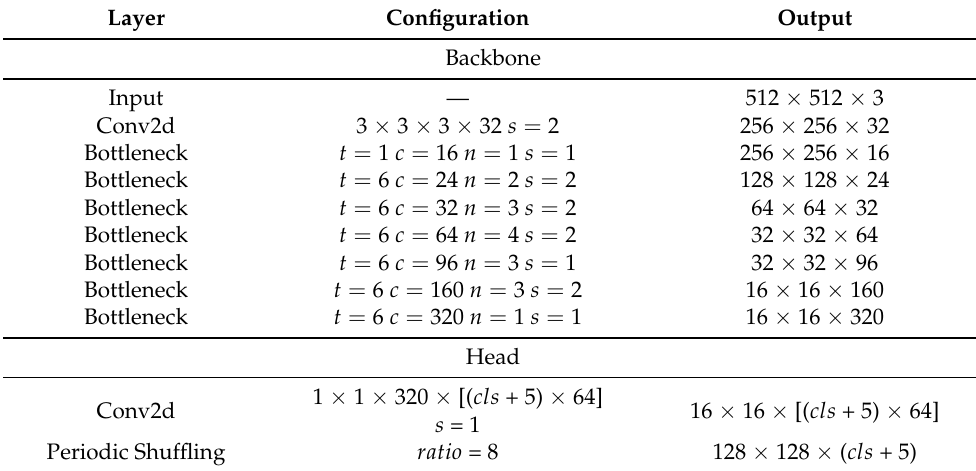
Table 1. Details of Our Network